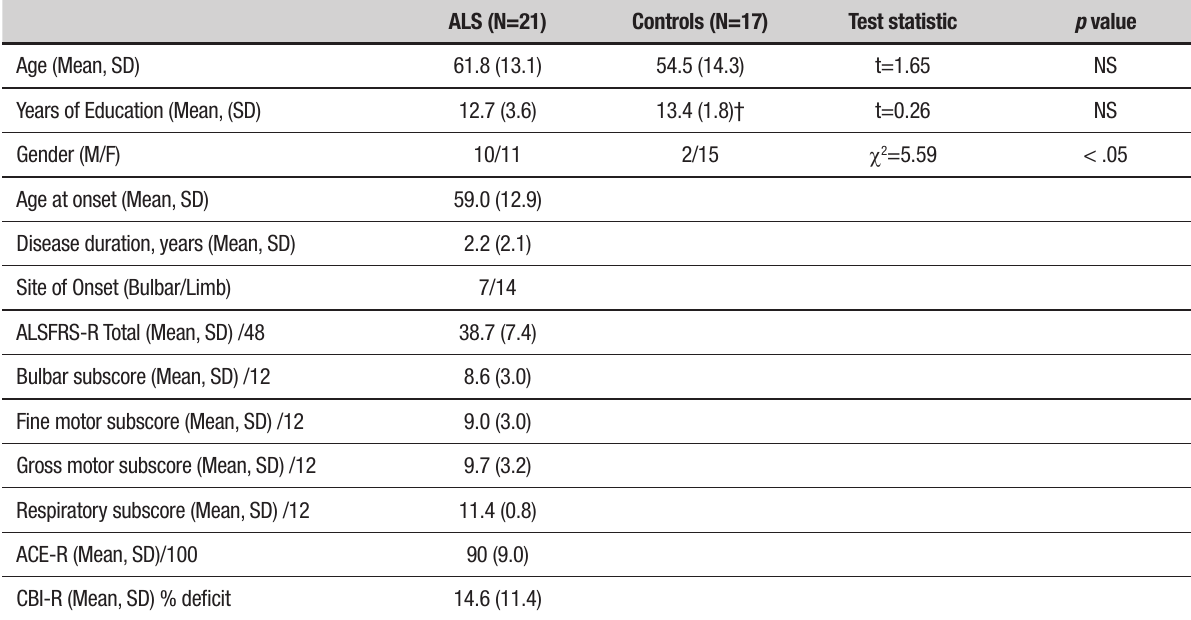
Table 1. Demographics of ALS patients and controls.